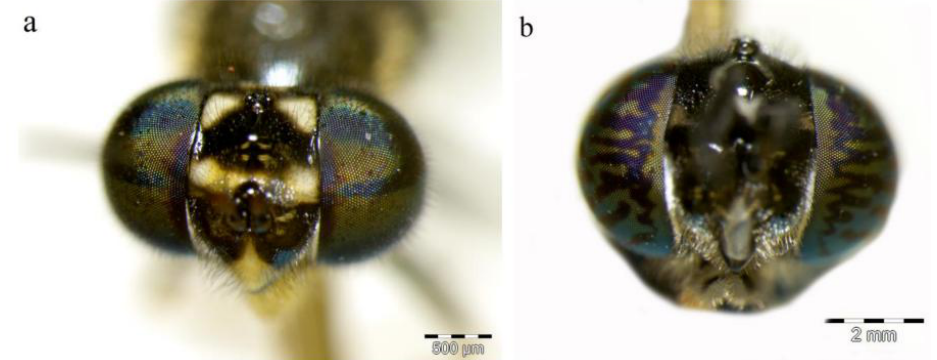
Figure 6. Frontal view of compound eyes: ( a ) Hairy compound eyes of H. fenestrata ; ( b ) Bare compound eyes of H. illucens